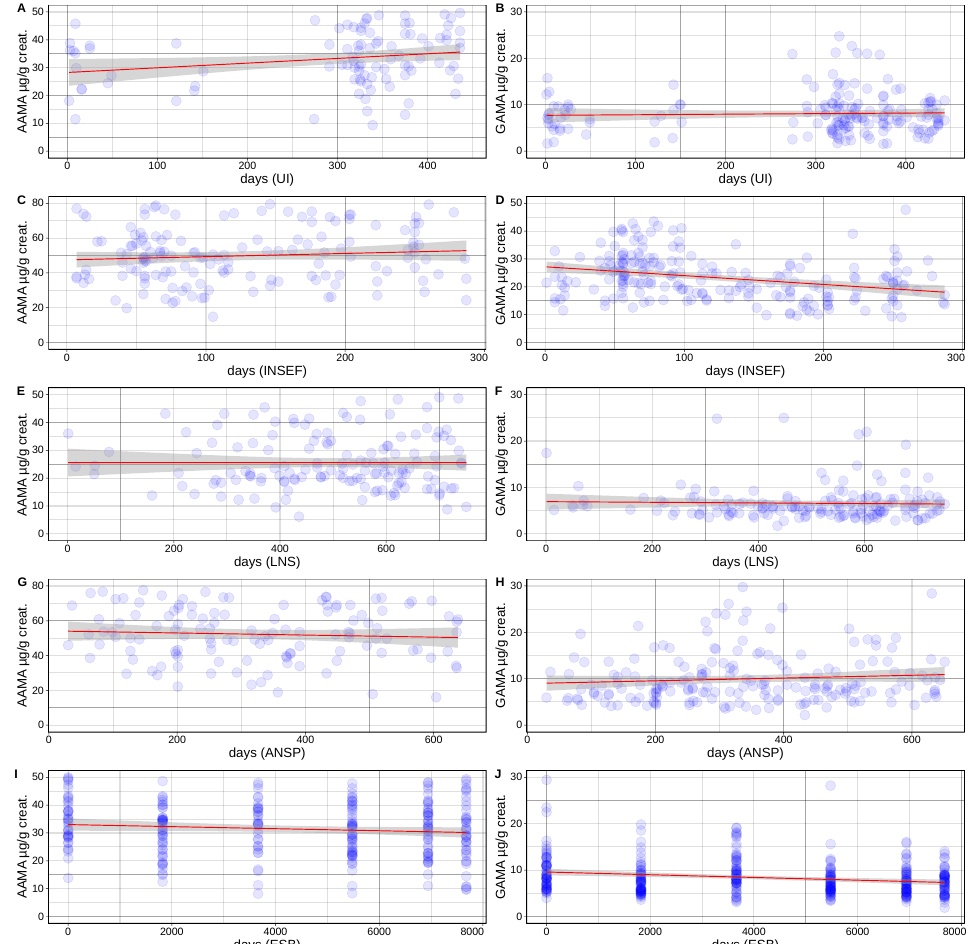
Figure A3. Time-trend of AAMA ( A , C , E , G , I ) and GAMA ( B , D , F , H , J ) in µg/g creatinine (per sam- pling day, 0 = first day of sampling) in individual data (non-smoker, adults) from HBM4EU-aligned studies from Iceland (Diet-HBM), Portugal (INSEF-ExpoQuim), Luxembourg (Oriscav-Lux2), France (ESTEBAN) and Germany (ESB). Linear fit in red, gray = 95% confidence